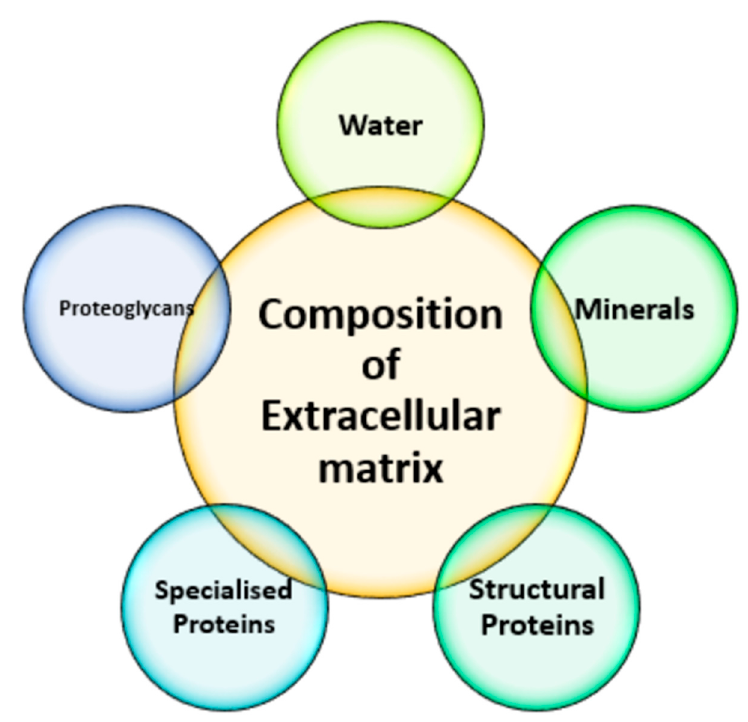
Figure 2. Composition of the ECM.